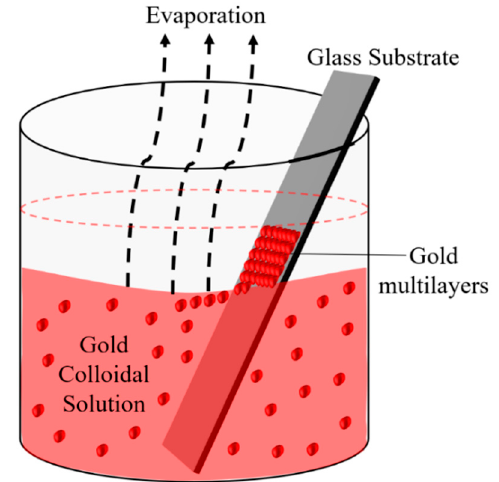
Figure 6. Schematic of the deposition of AuNP (Nanoparticle) multilayers by a thermal convection method (modified from Bathini [42]